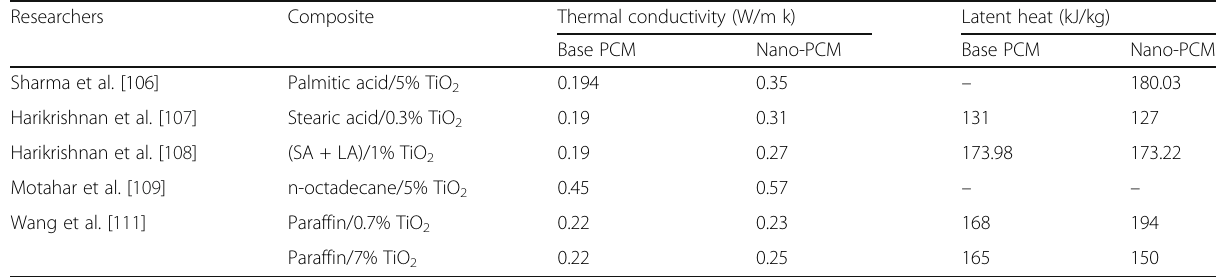
Table 3 Summary on thermal conductivities and the latent heat of TiO 2 nano-PCMs